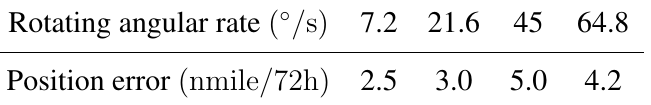
Table 7. Position error (Group